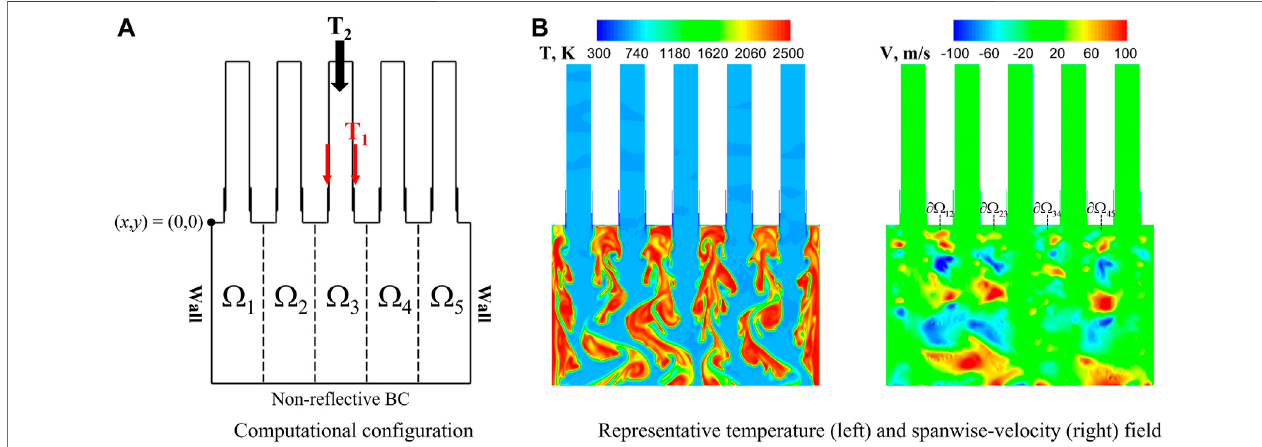
FIGURE 8 | (A) Computational con fi guration and (B) representative temperature and spanwise-velocity fi eld of 2D-planar multi-injector model rocket combustor.